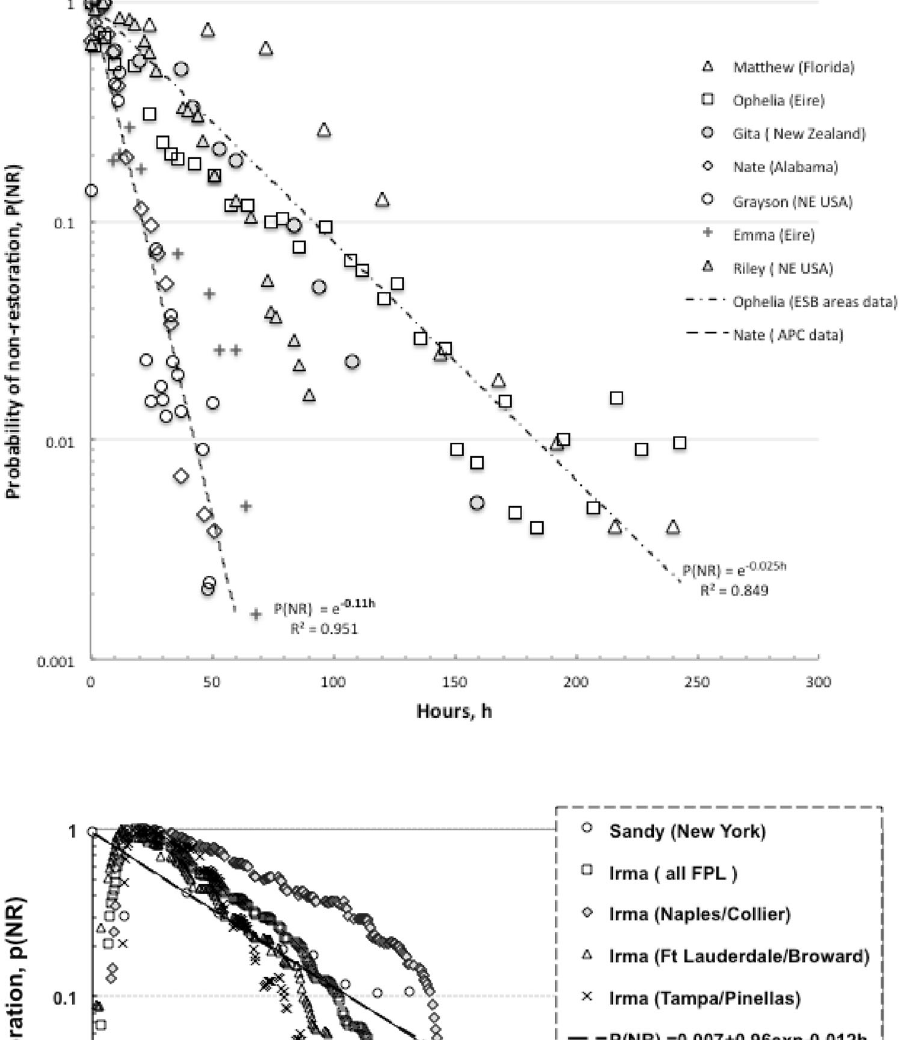
Fig. 3 Comparison of